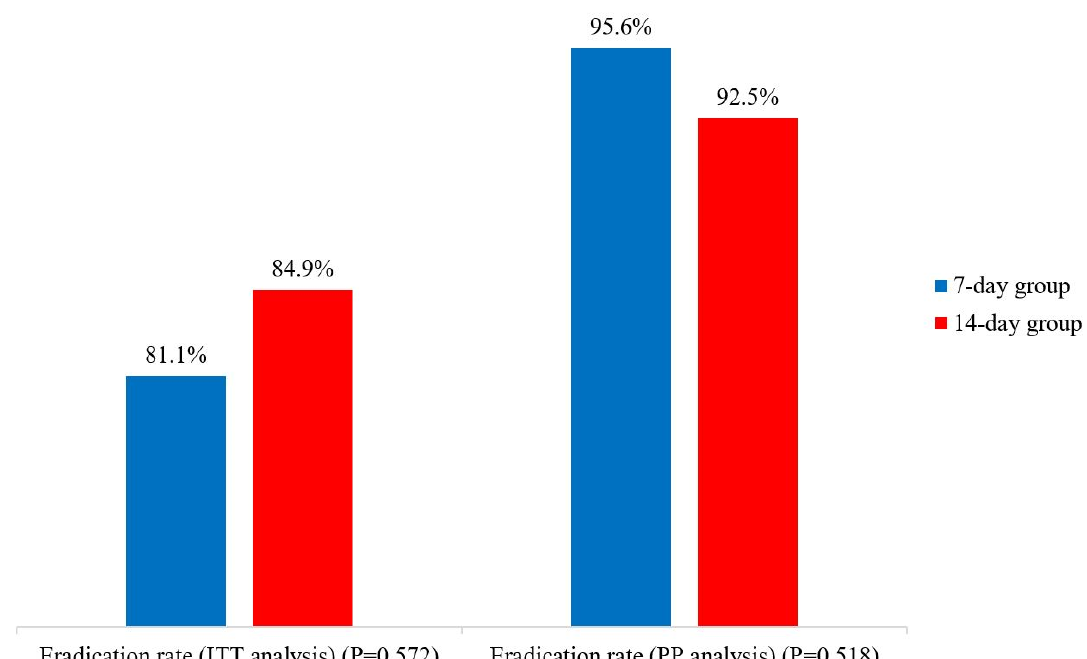
Figure 1. Eradication extents of the two study groups. ITT analysis (Intention-to-treat analysis), PP analysis (Per-protocol analysis).